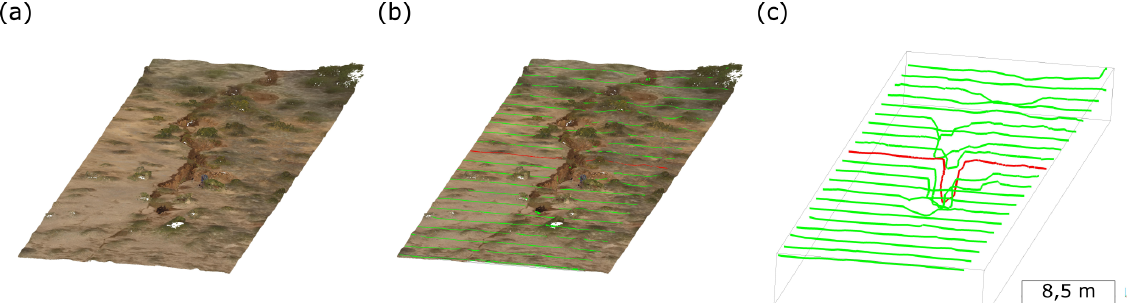
Figure 5. (a) view of the 3-D point cloud, coloured with the photos; (b) transects every 5m overlayed on the 3-D point cloud; (c) transects isolated. Source: CloudCompare.